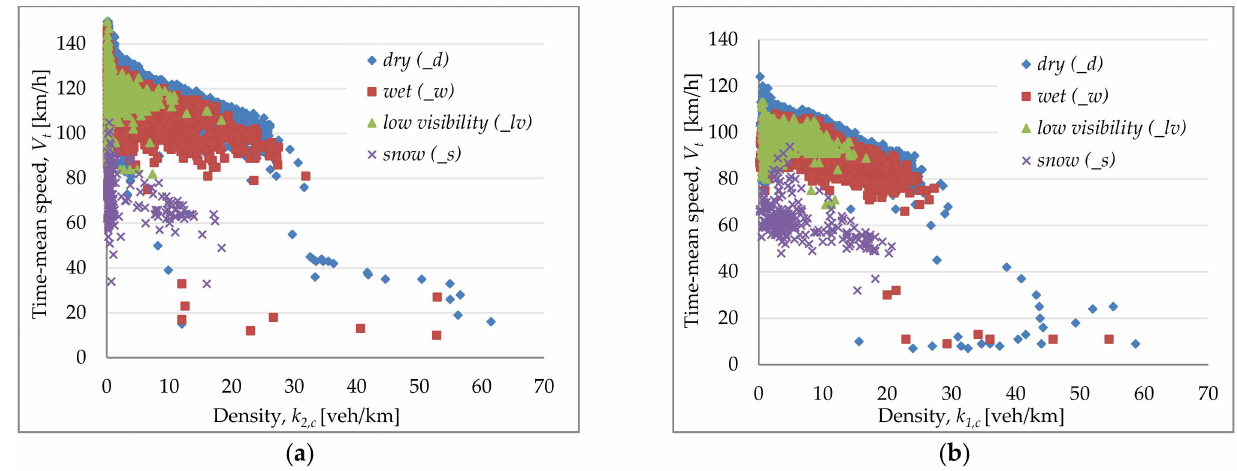
Figure 1. Example of scatter graph of time mean speed vs. traffic density on the carriageway near Ljubljana in different traffic lanes: ( a ) lane 2—left (overtaking) lane; ( b ) lane 1—right